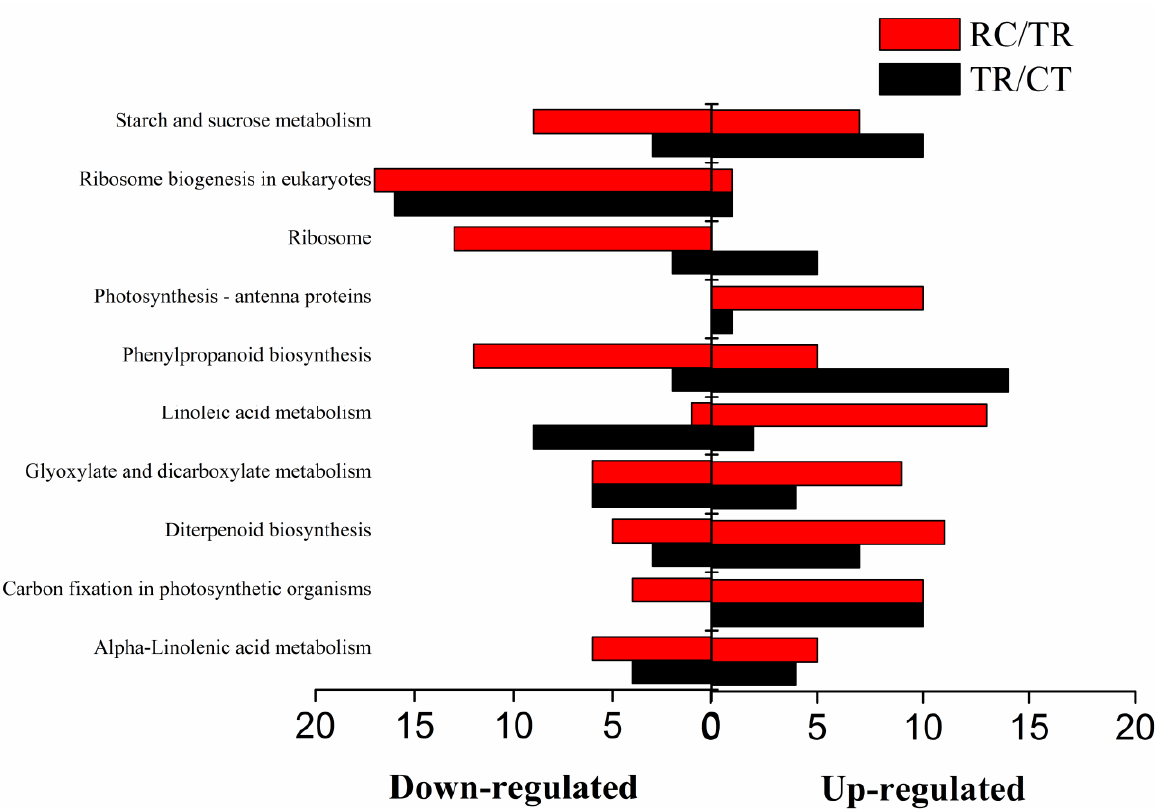
Figure 6. Functional characterization of chilling and recovery-responsive genes under chilling and/or subsequent recovery. CT: Normal-temperature treatment. TR: Chilling treatment. RC: Recovery to normal-temperature treatment. TR/CT: From normal temperature to chilling. RC/TR: From chilling recovery to normal temperature. The red columns show the differential expressed genes under RC/TR. The black columns show differential expressed genes under TR/CT.